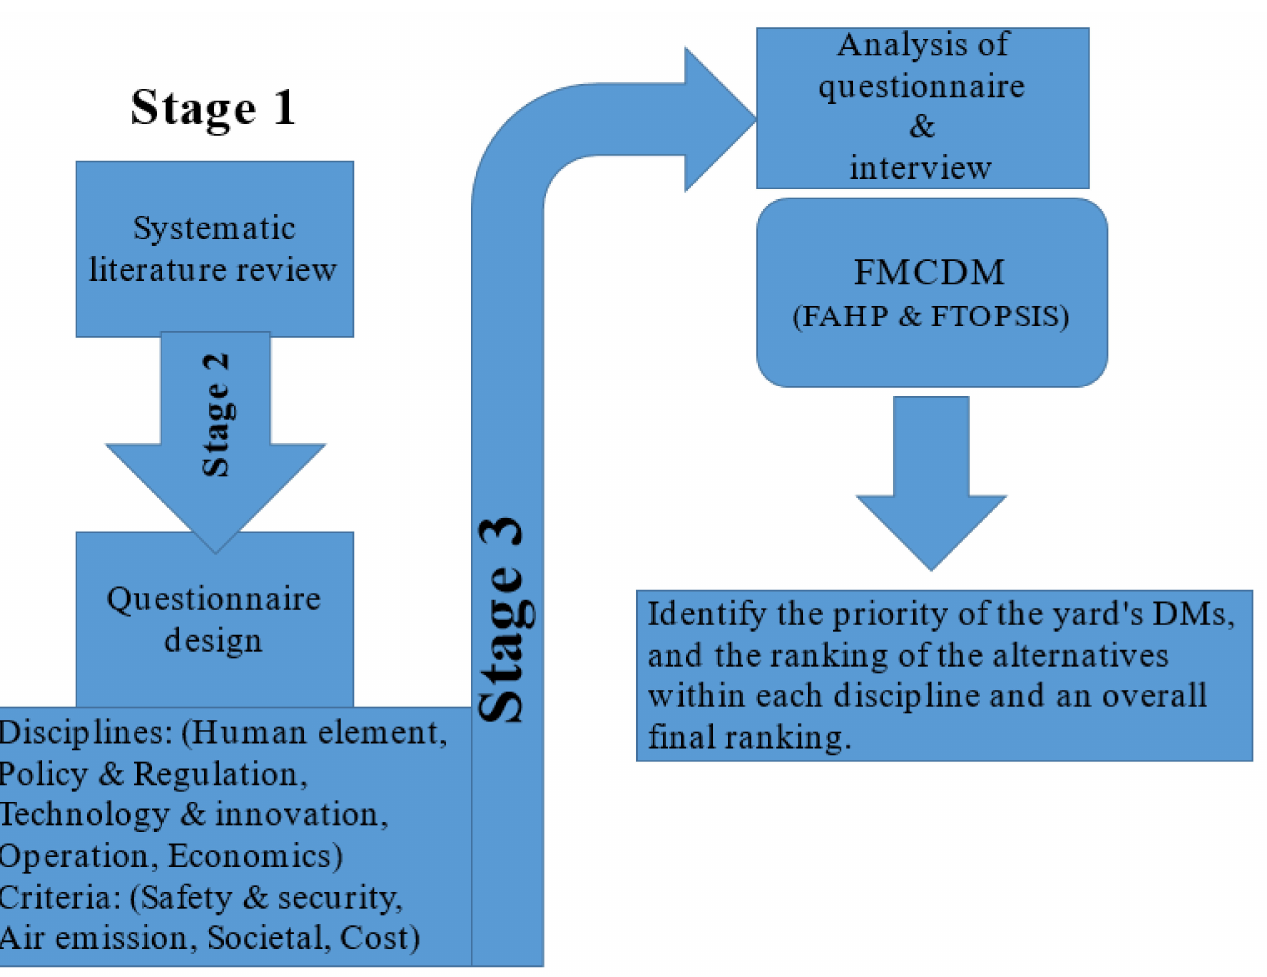
Figure 3. The structure and flow of analysis of the